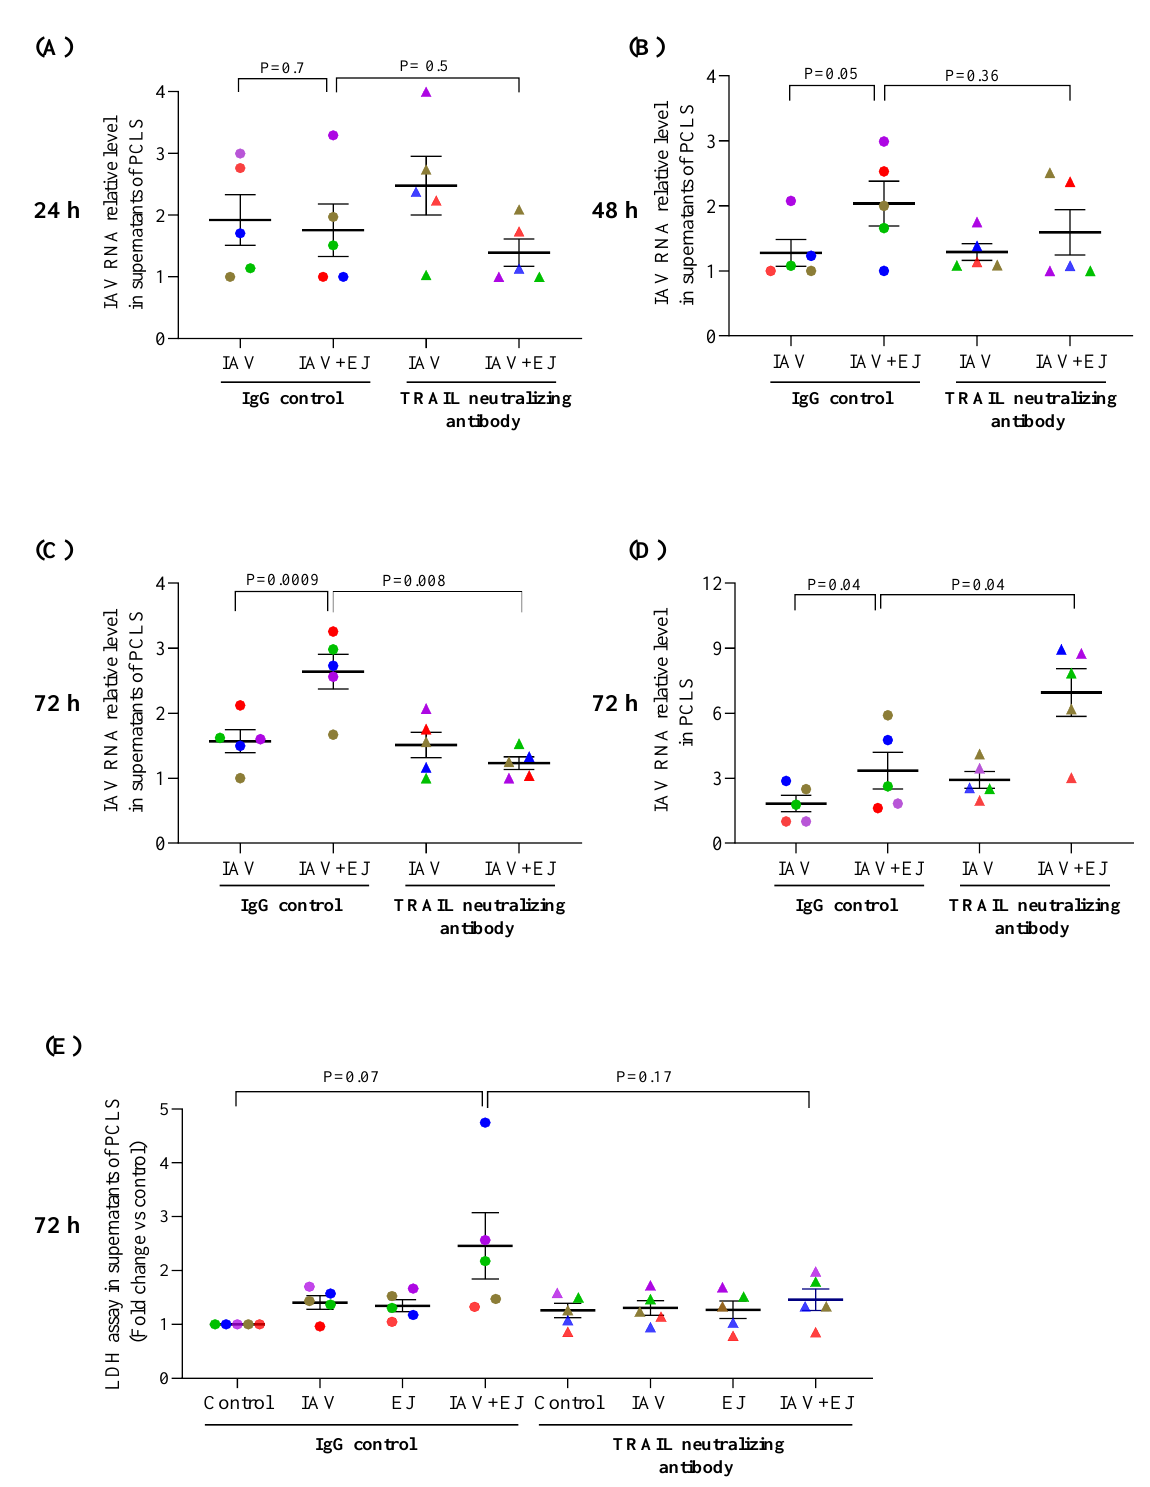
Figure 3. TRAIL neutralizing antibody regulated influenza A virus (IAV) infection in human precision-cut lung slices (PCLS). PCLS were treated with IAV and E-juice (EJ) in the presence or absence of a TRAIL neutralizing antibody (50 ng/mL) and IgG control (50 ng/mL) for 24, 48, and 72 h. IAV load in supernatants ( A – C ) and lung tissue ( D ) was analyzed by RT-PCR. Cytotoxicity ( E ) was analyzed by the LDH assay. Each data point (colored dot) represents the average of 3 replicates from each respective individual donor ( n = 5 donors). Horizontal lines indicate mean ± SEM. Paired t -test was used to analyze the data.